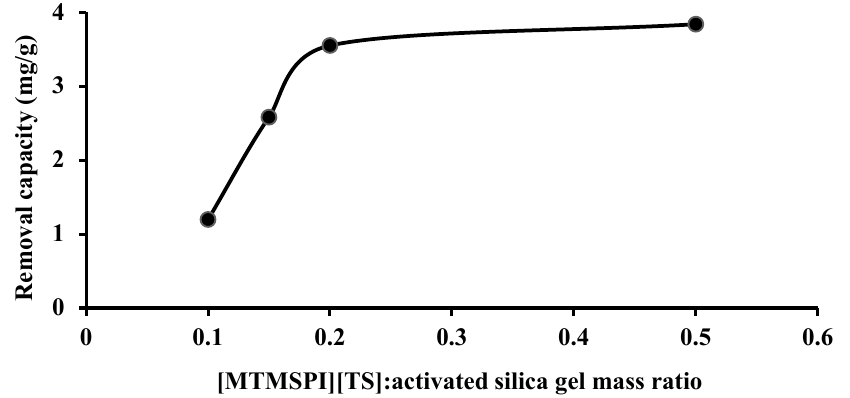
Figure 5. The effect of different [MTMSPI][TS]:activated silica gel mass ratios on the removal process of Pb(II) ions onto Si-TS-SSIL.